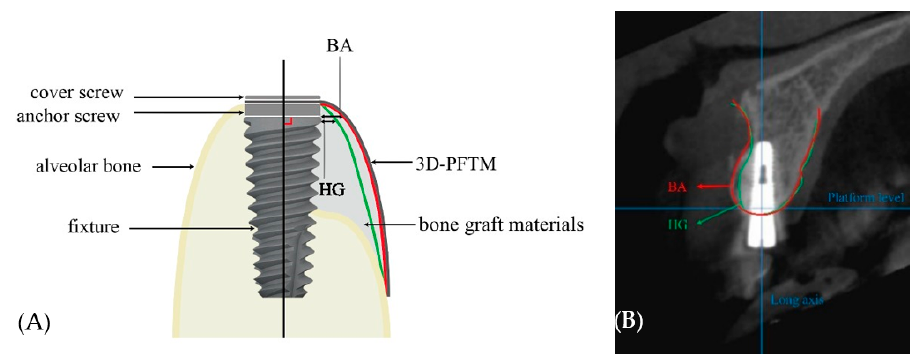
Figure 2. Method of radiographic analysis. ( A ) A line parallel to the long major axis of the implant is drawn, as well as a perpendicular line extending buccally at the level of the implant platform. ( B ) Table 3. D-PFTM, three-dimensional preformed titanium mesh; BA, bone augmentation immediately after surgery; HG, hard tissue gain after 6 months of healing.